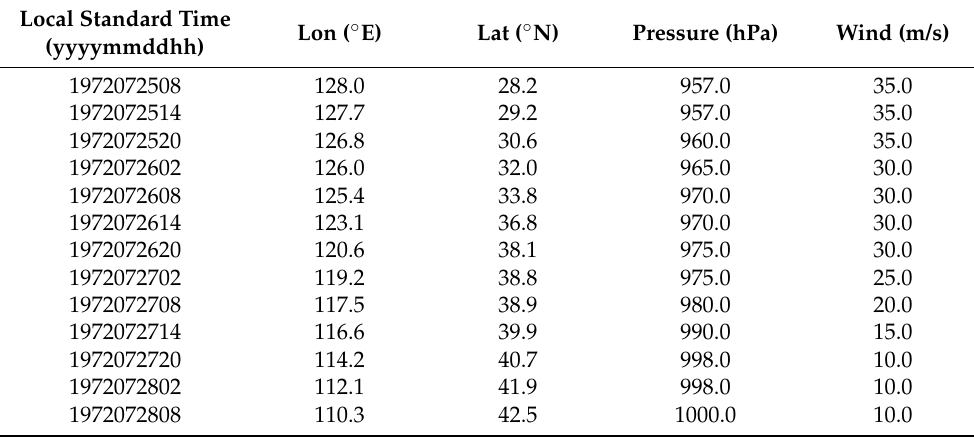
Figure 1. Typhoon routes and positions of tidal stations. Mauve and blue solid lines denote the routes of Typhoons 7203 and 7303, respectively. Circles represent the Local Standard Time. Red asterisks show the positions of 10 tidal stations. Table 1. Best track, central pressure, and maximum wind speed for Typhoon 7203. Local Standard